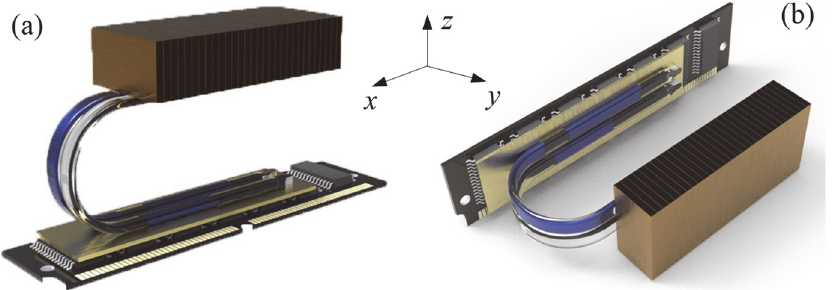
Figure 3. Position of the heat sink: ( a ) 0°; ( b ) 90°.